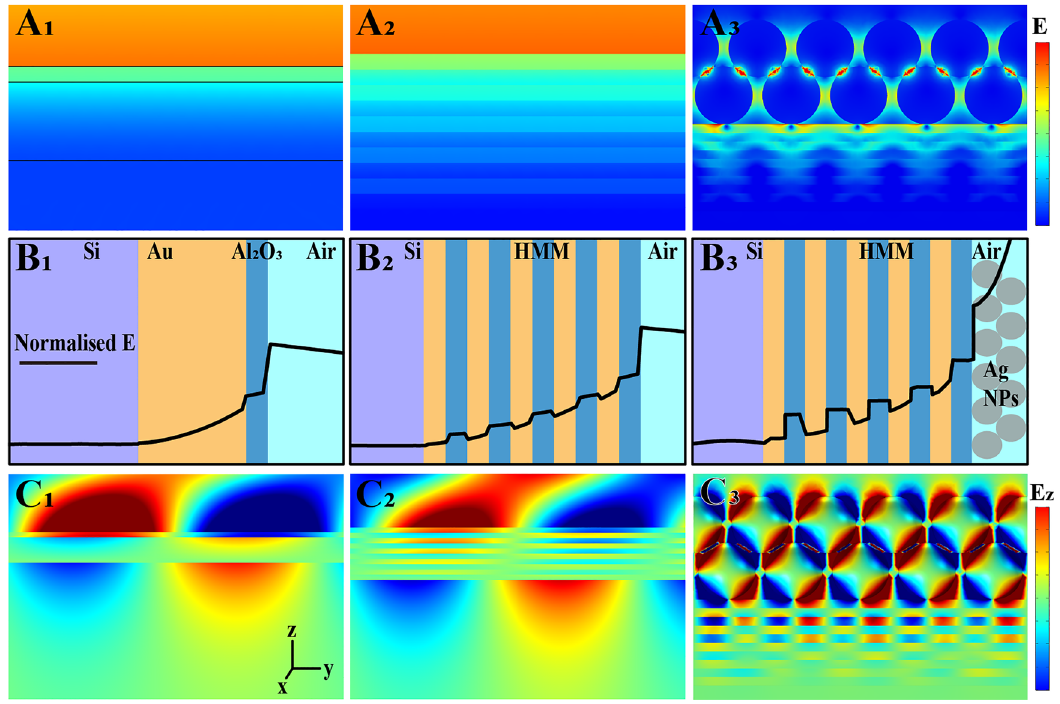
Figure2: (A)ElectricfielddistributionforAunanoblock,hyperbolicmetamaterial(HMM)andHMM/2Ag.(B)Fieldprofileforvariousstructures. (C) Diagram of the propagation of the Ez field (multimedia